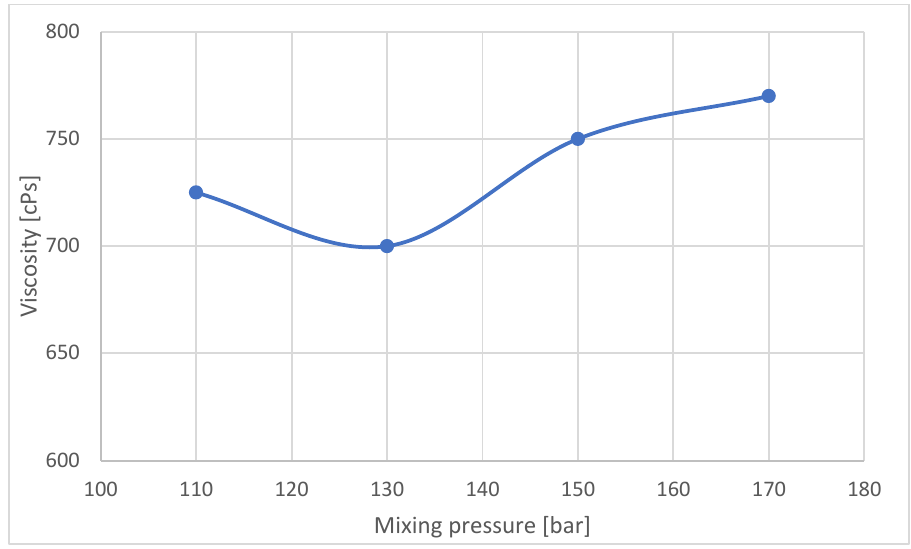
Figure 13. Polyol viscosity according to the mixing pressure during the mixing cycle.